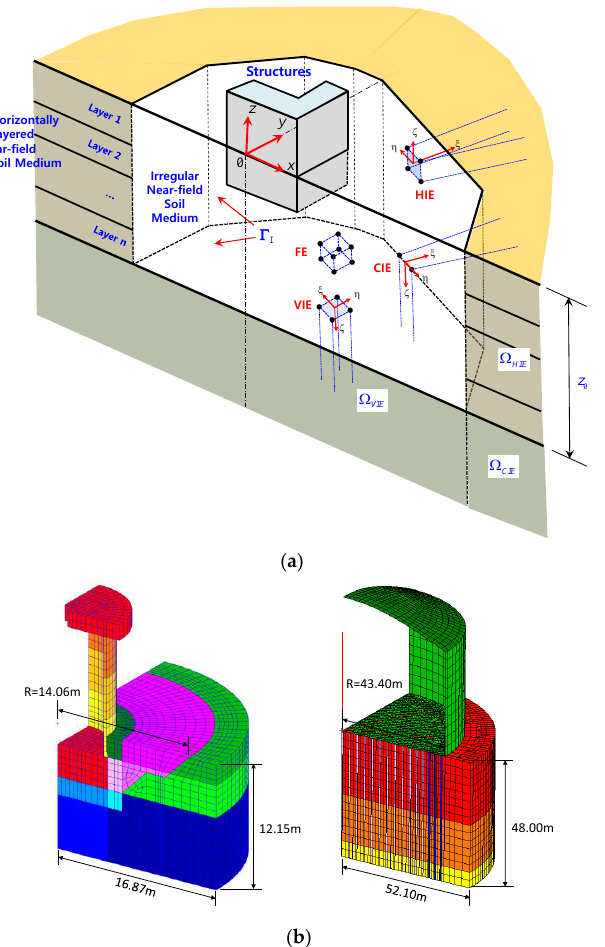
Figure 2. Modeling of soil-structure interaction system using KIESSI-3D program utilizing finite and dynamic infinite elements: ( a ) Modeling concept; ( b ) Modeling examples.